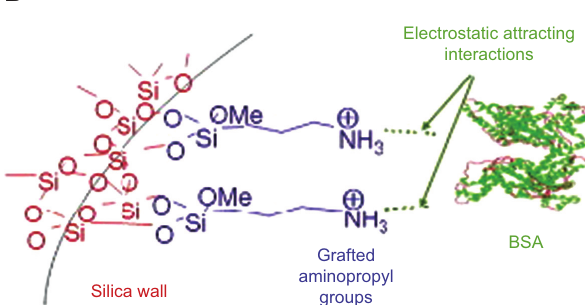
Figure 5 Transmission electron micrograph (TEM) of Mg LDH nanoparticles